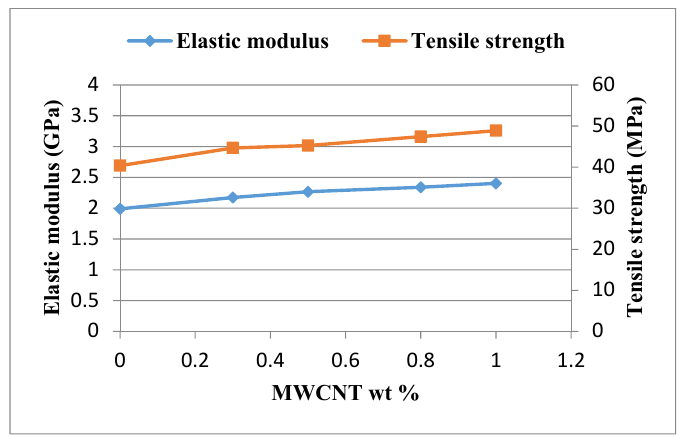
Figure 6. Elastic modulus and tensile strength of the nanocomposite varied with different MWCNT loadings.